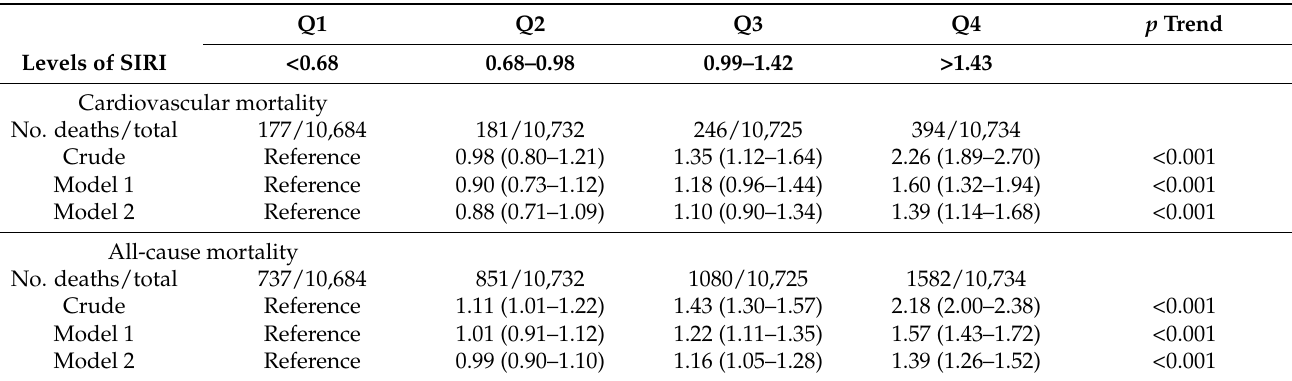
Table 4. HRs (95% Cis) of cardiovascular diseases and all-cause mortality according to quartiles of SIRI among the general adult population in NHANES,